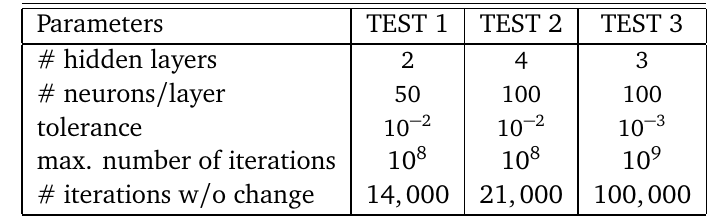
Table 3: Architectures for the MLP of three different tests for the reconstruction of the momentum fractions at NLO in QCD. All parameters are taken to be the same for X and Z REC REC